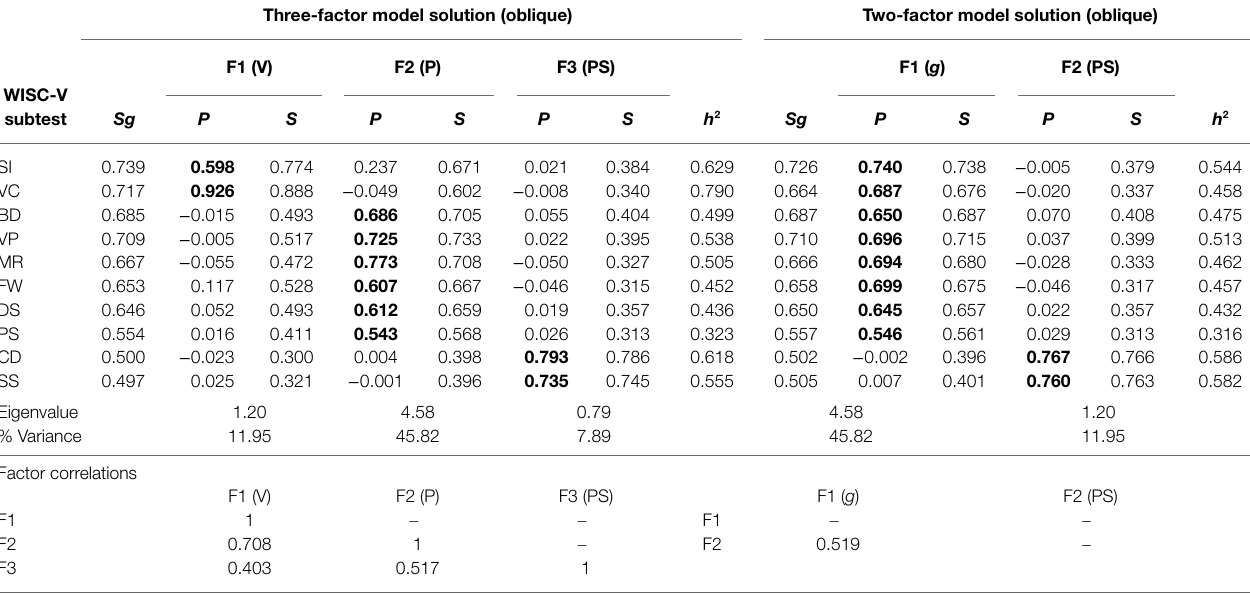
TABLE 4 | Exploratory factor analysis of the 10 WISC-V primary subtests: three- and two-factor model solutions (oblique) with promax rotation for the EFA sample ( n = 823).